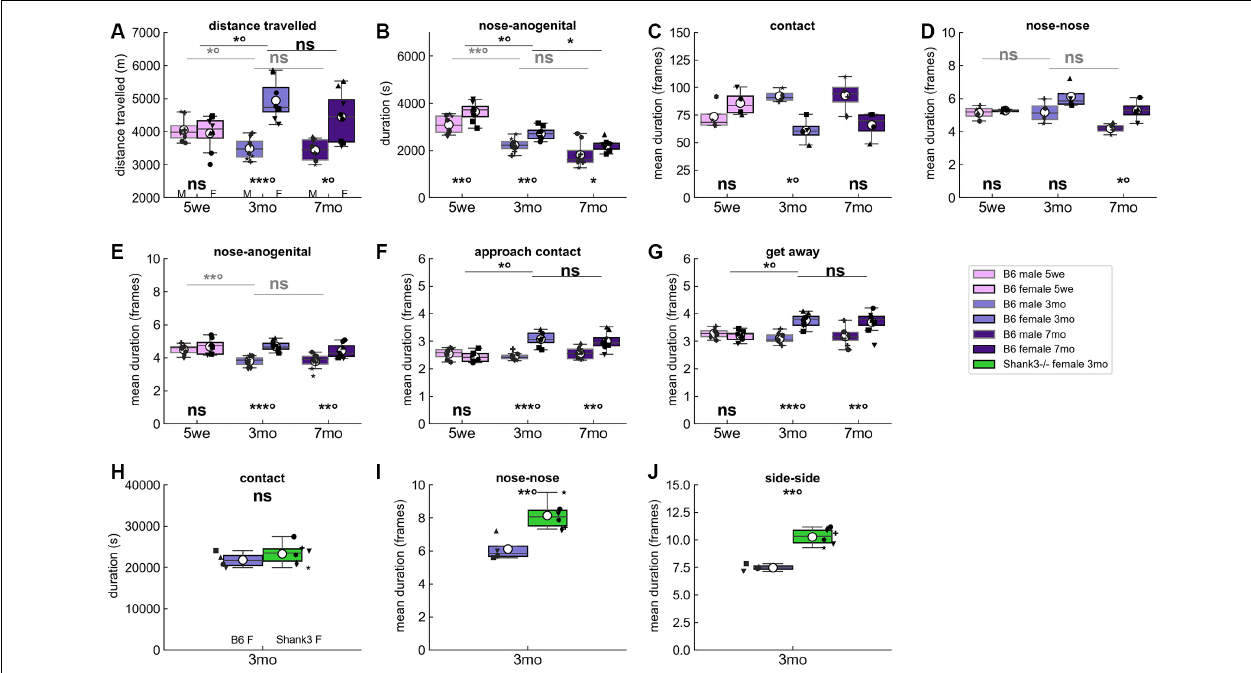
FIGURE 2 | Spontaneous behaviors in B6 male and female pairs as well as in Shank3 − / − female pairs over three nights. (A) Total distance traveled over the three nights of recording in B6 male (M) and female (F) pairs at the three age classes tested. Age- and sex-related variations in the (B) total time spent in nose-anogenital contact, (C) mean duration of contact events (i.e., contacts in a broad sense without any specific body part involved), (D) mean duration of nose-nose contact events, (E) mean duration of nose-anogenital contact events, (F) mean duration of social approach events, and (G) mean duration of get away events over the three nights of recording. Each black dot corresponds to an individual in (A,B,E–G) with a similar shape for the two individuals of the pair, while in (C,D) each dot corresponds to a pair since the behaviors are symmetrical (Mann–Whitney U -tests used to test for differences between sexes within each age class; Kruskal–Wallis test followed by Wilcoxon paired test if significant to test for differences between 5 weeks and 3 months and between 3 months and 7 months within each sex). Comparisons between B6 female pairs aged 3 months and age-matched Shank3 − / − female pairs of the (H) total time spent in contact, (I) mean duration of nose-nose contact events, and (J) mean duration of side-side contact events over the three nights. Each black dot corresponds to a pair since the behaviors are symmetrical (Mann–Whitney U -tests used to test for differences between genotypes). Uncorrected p -values: ns: non significant, * p < 0.05, ** p < 0.01, ∗∗∗ p < 0.001. P -values followed by ◦ survived a correction for multiple testing over age